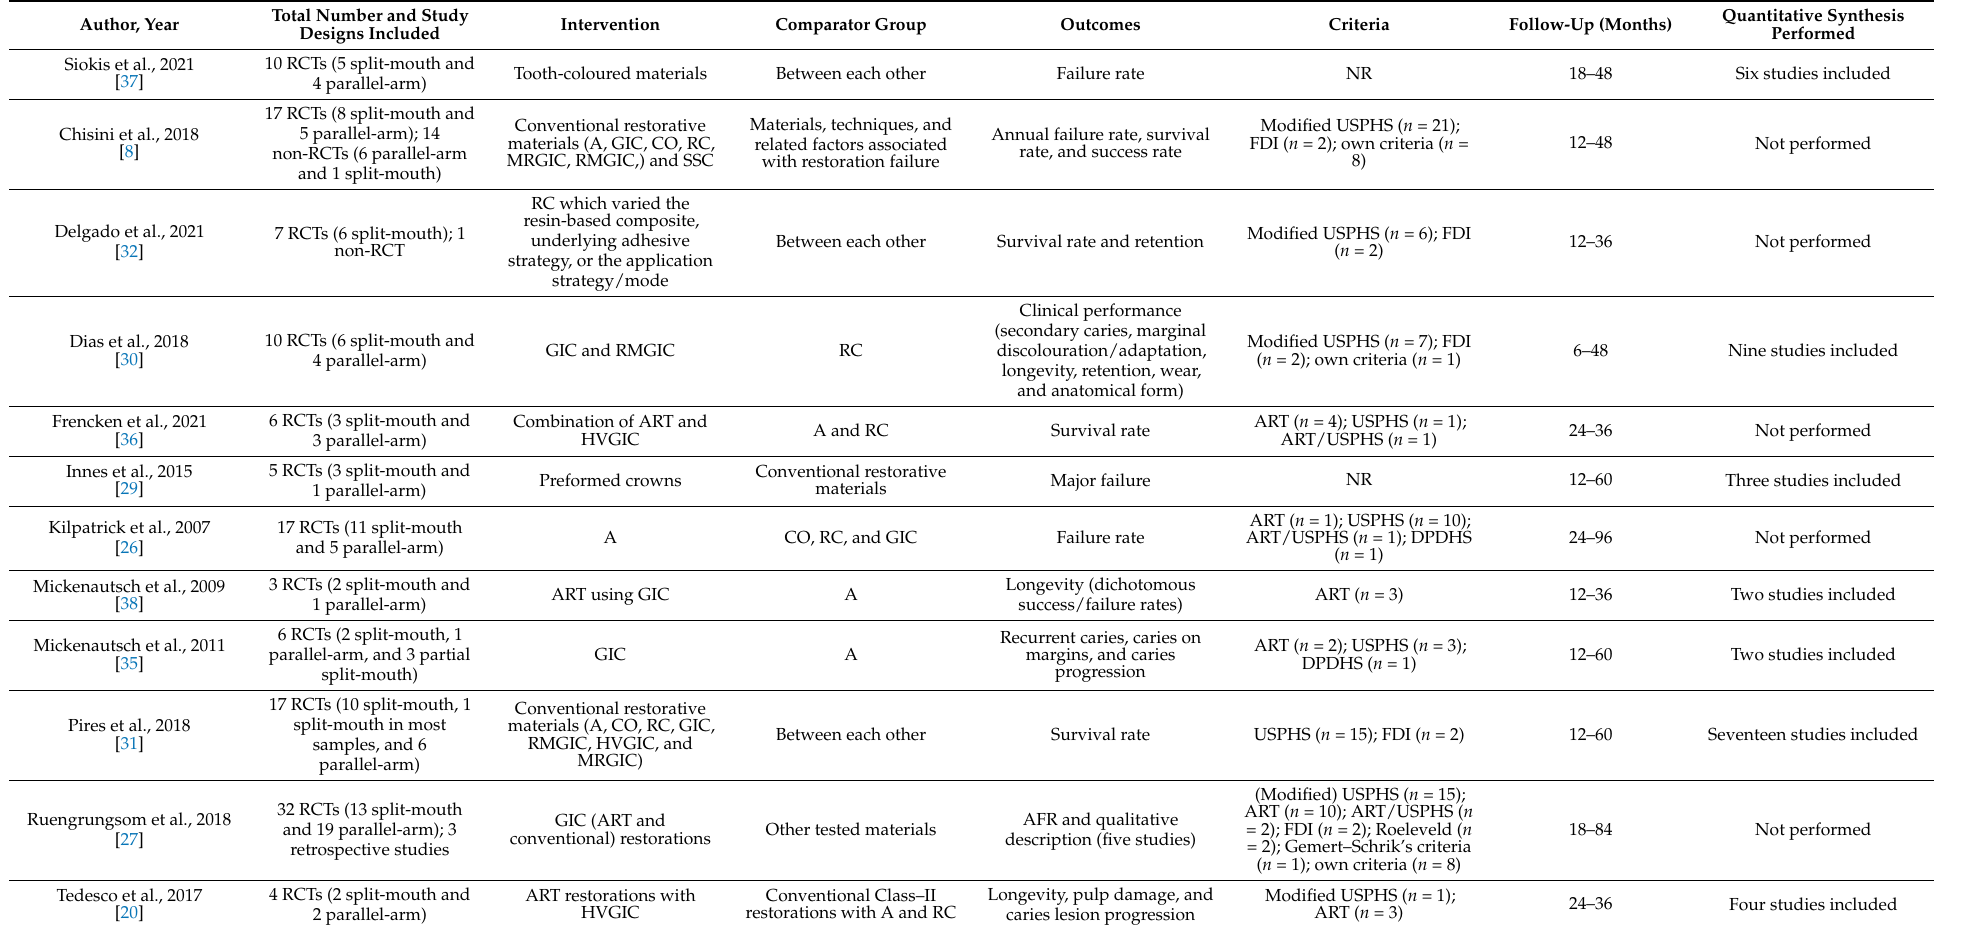
Table 1. Main characteristics of the included